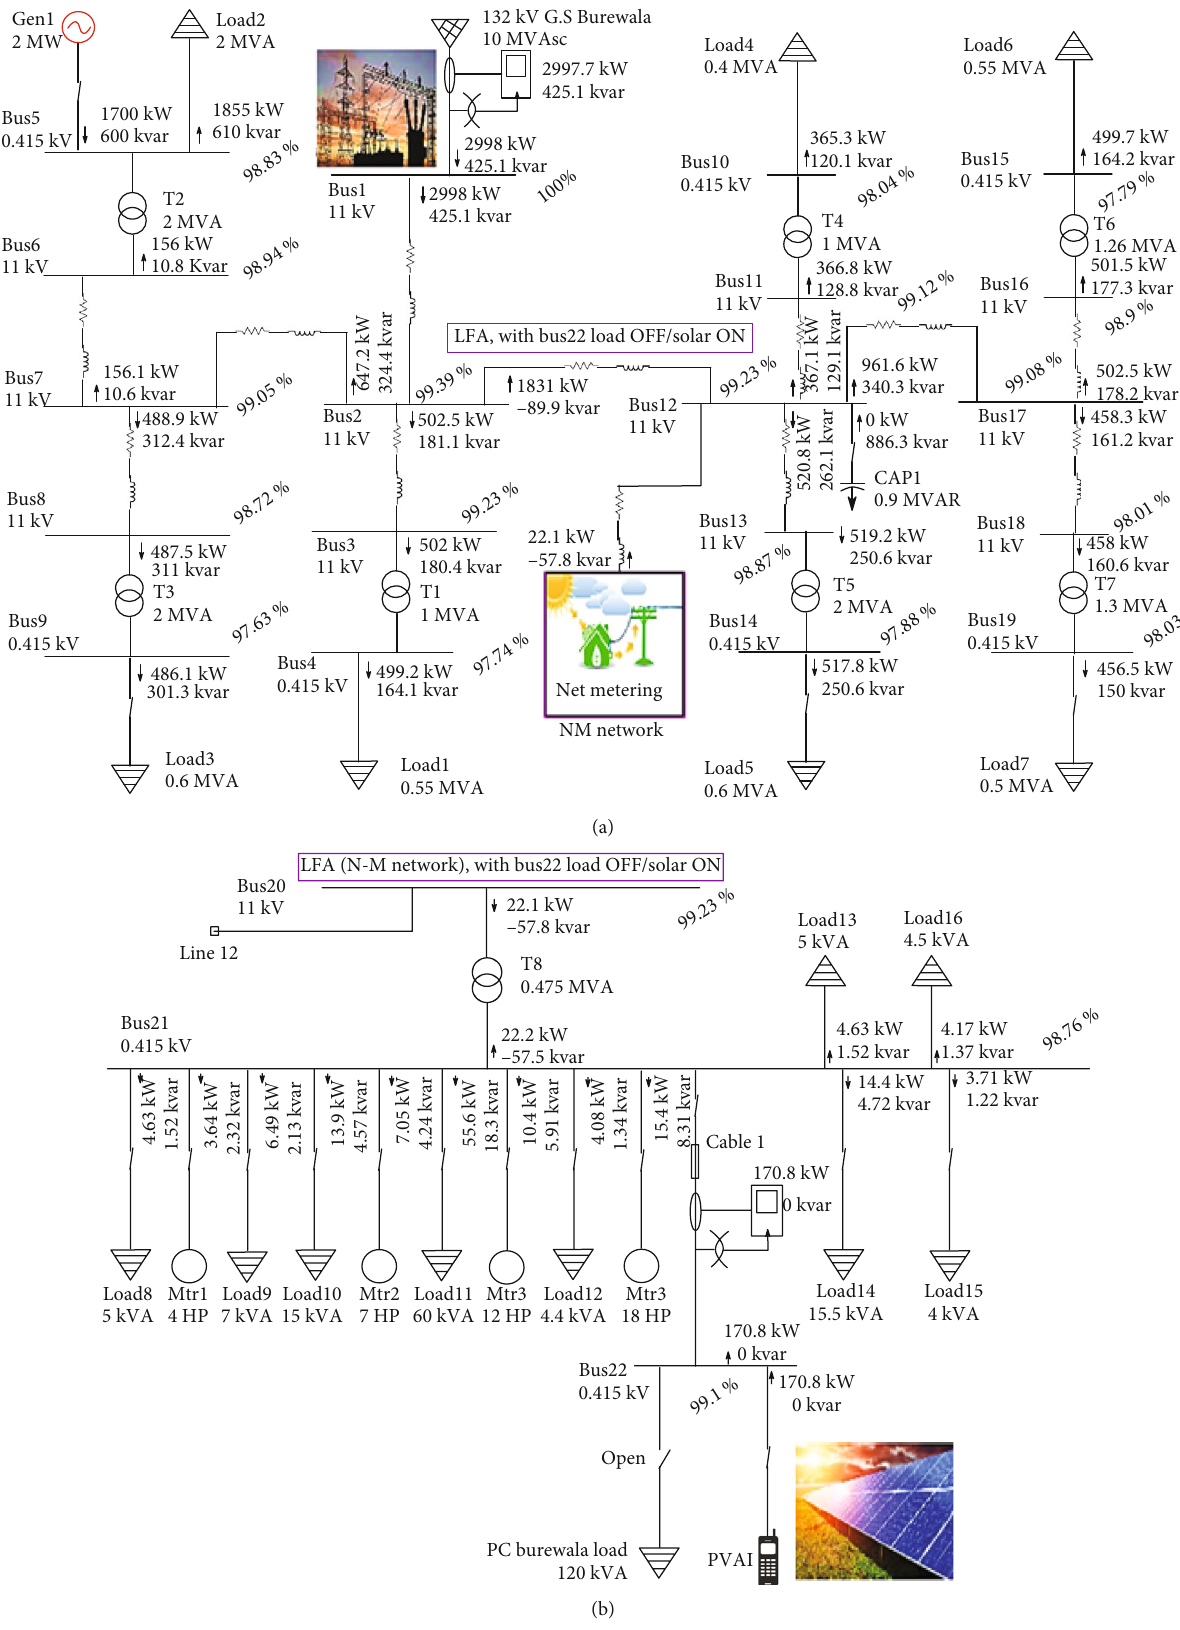
Figure 5: (a) Load fl ow analysis with Bus22 load OFF/solar ON. (b) Load fl ow analysis (N-M network) with Bus22 load OFF/solar